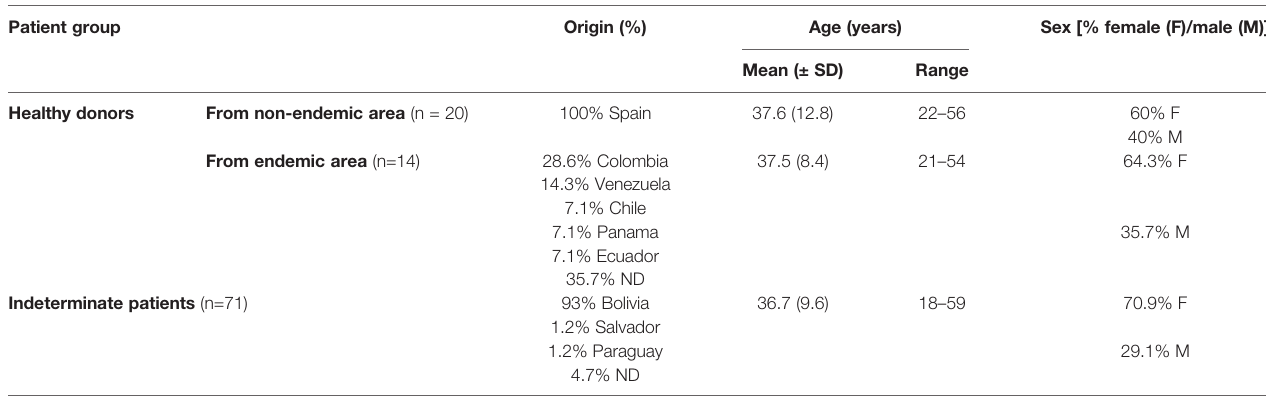
TABLE 1 | Epidemiological and demographic data of the study